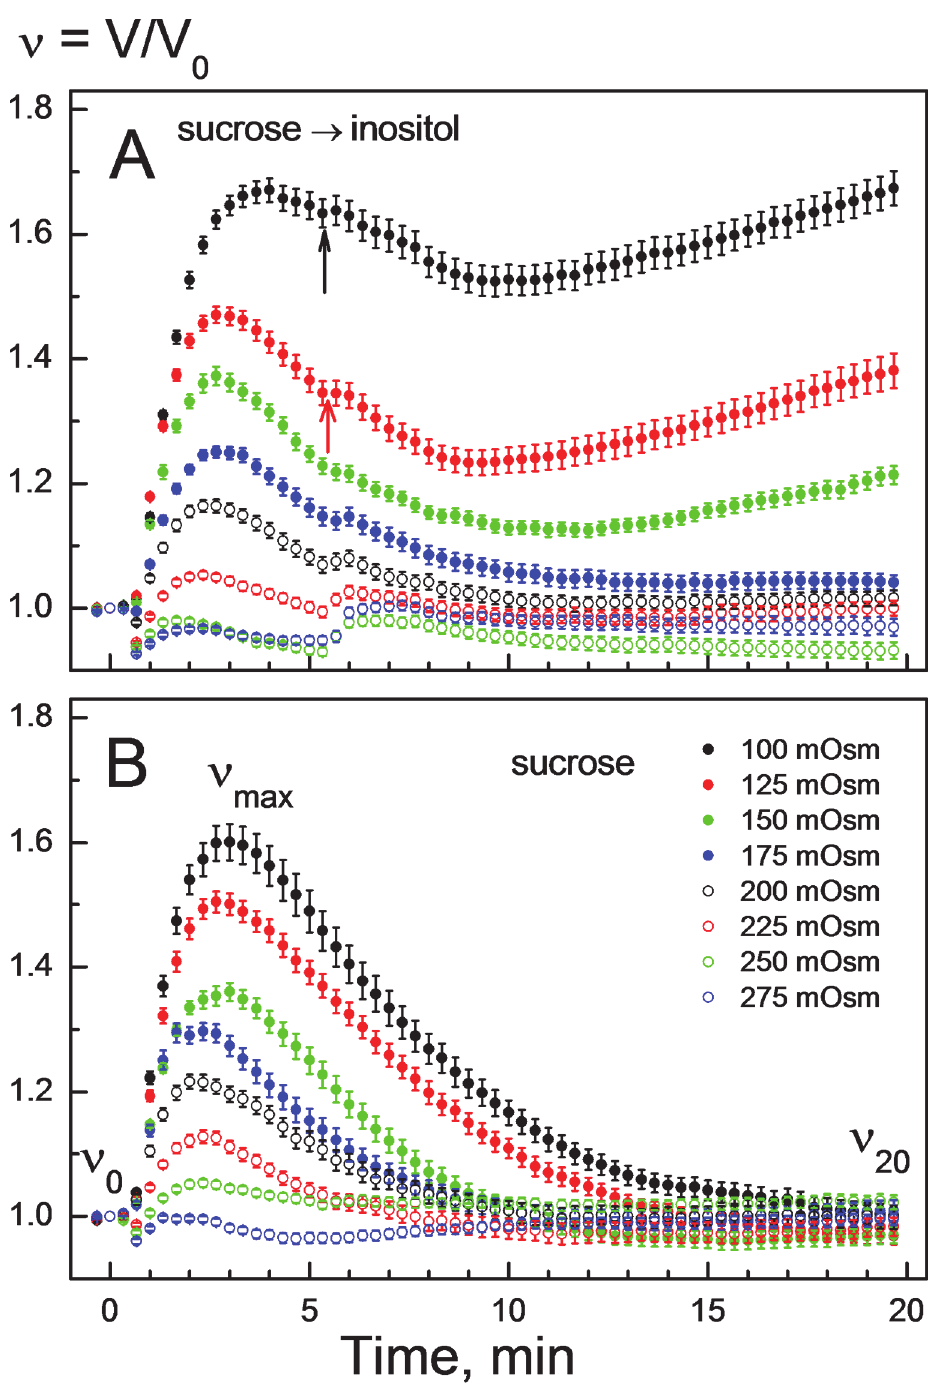
Fig 2. Volume changes of HEK293 cells in response to solutions of varying osmolality and composition. At time * 30 s, the cells were first transferred from isotonic growth medium to a sucrose- substituted solution having osmolality of 100, 125, ... 250 or 275 mOsm. Thereafter, the hypotonic sucrose solutions were replaced at time * 5 min with myo-inositol solutions of the same osmolalities ( A ). In contrast, the cells were exposed for 20 min to sucrose solutions only ( B ). After the initial swelling in the presence of sucrose, the cells were capable of RVD over the entire hypotonicity range ( B ). A nearly complete RVD also occurred in slightly hypotonic solutions of myo-inositol ( A , * 175 – 275 mOsm). Application of more diluted myo-inositol solutions (100 – 150 mOsm; t (cid:4) 5 – 9min) considerably inhibited cell shrinkage via